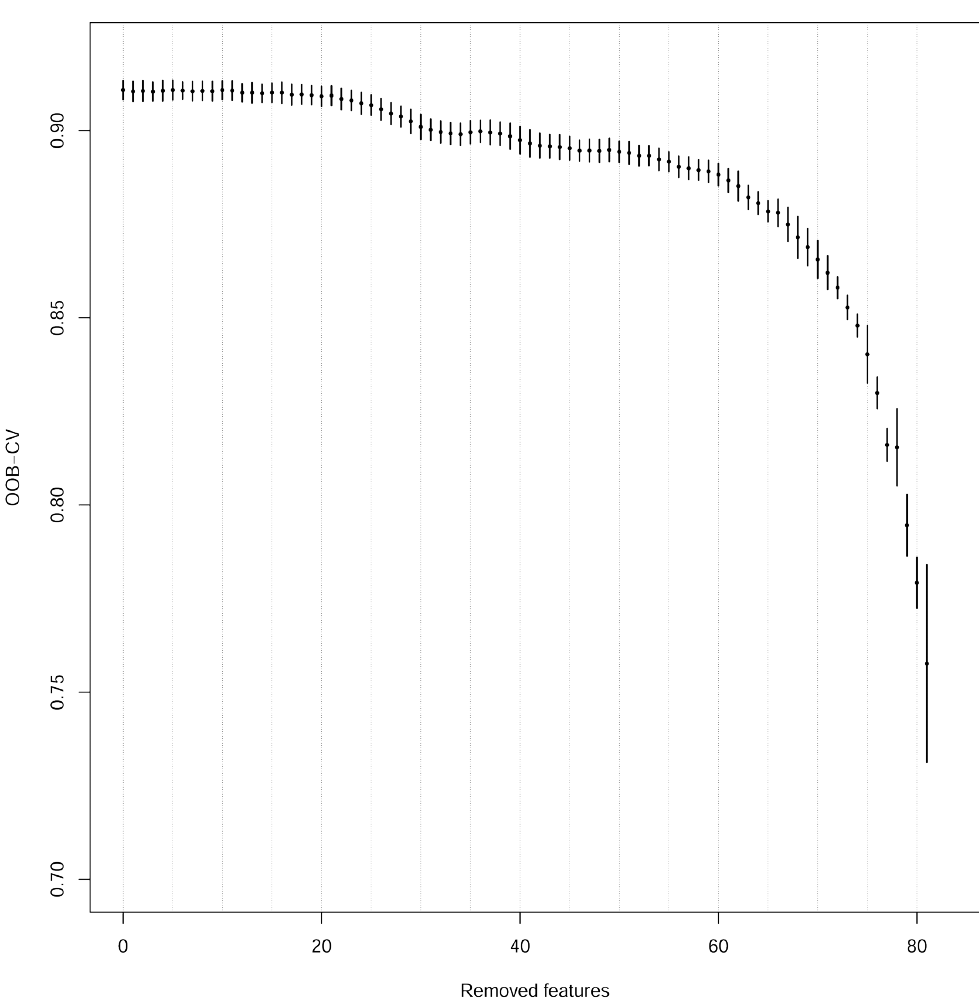
Figure 4. Accuracy metrics achieved while decreasing the number of predictors. Table 6. Features selected for the final model. LiDAR features were derived from a single dataset recorded between August 2016 and March